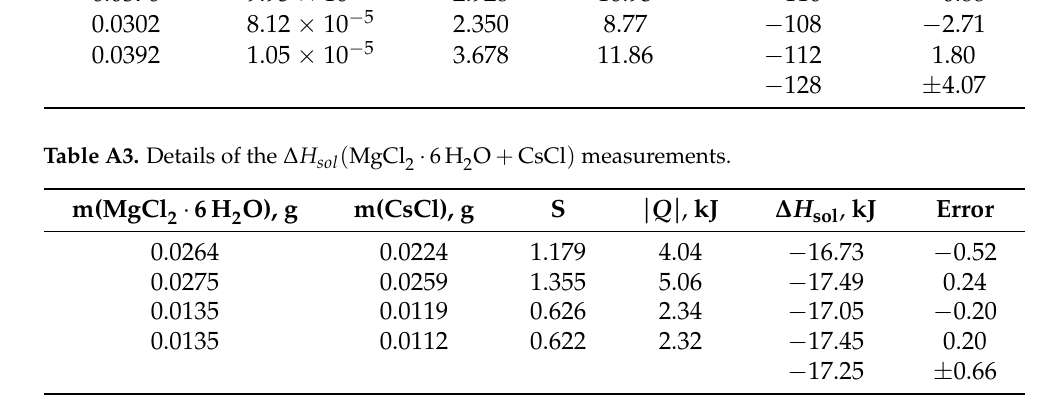
· CsCl · 6H O ) measurements. 2 2